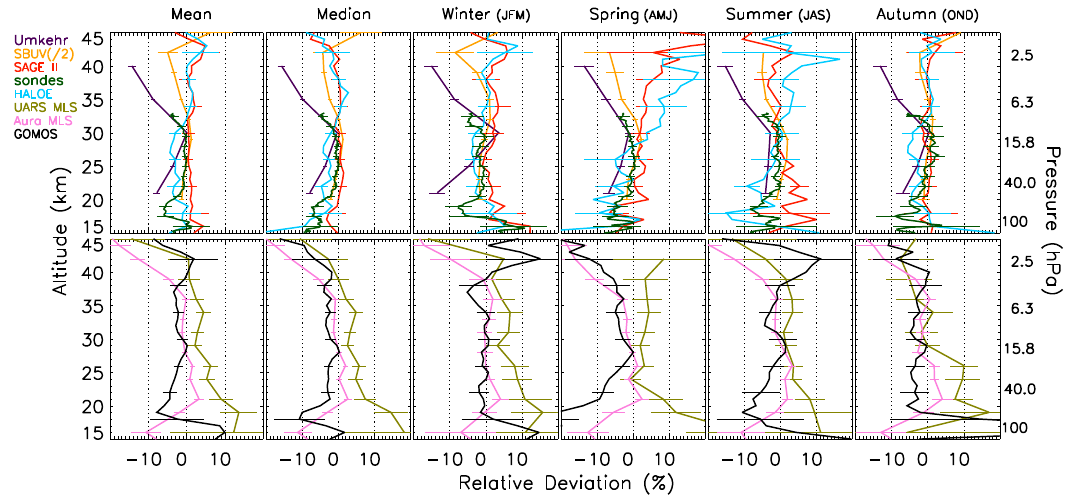
Fig. 8. Vertical distribution of average relative differences of the coincident ozone measurements of various observations with lidar. Top panel: instruments with more than 10 years of data. Bottom panel: instruments with less than 10 years of data. The dotted vertical lines represent − 10, 0, and 10% and the error bars correspond to twice the standard error. Approximate pressure levels corresponding to the geometric altitudes are also shown on the right axes.